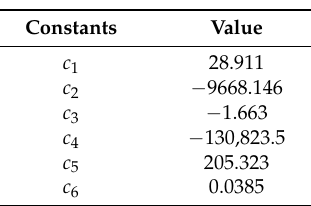
Table 2. Constants c 1 to c 6